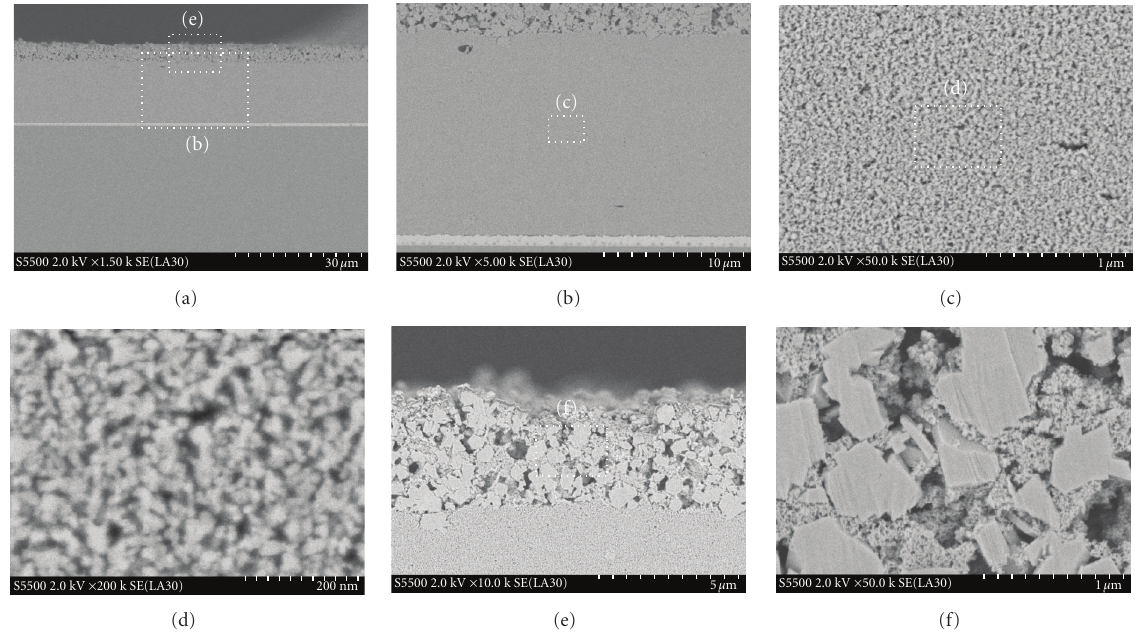
Figure 4: Cross-sectional SEM images of a porous double-layered TiO 2 electrode polished with an Ar-ion beam (nanocrystalline-TiO 2 layer: 14 μ m thick; submicron crystalline-TiO 2 layer: 5 μ m thick). (a) is the most zoomed-out image. White dotted quadrangles show the zoomed-in area for the other images.